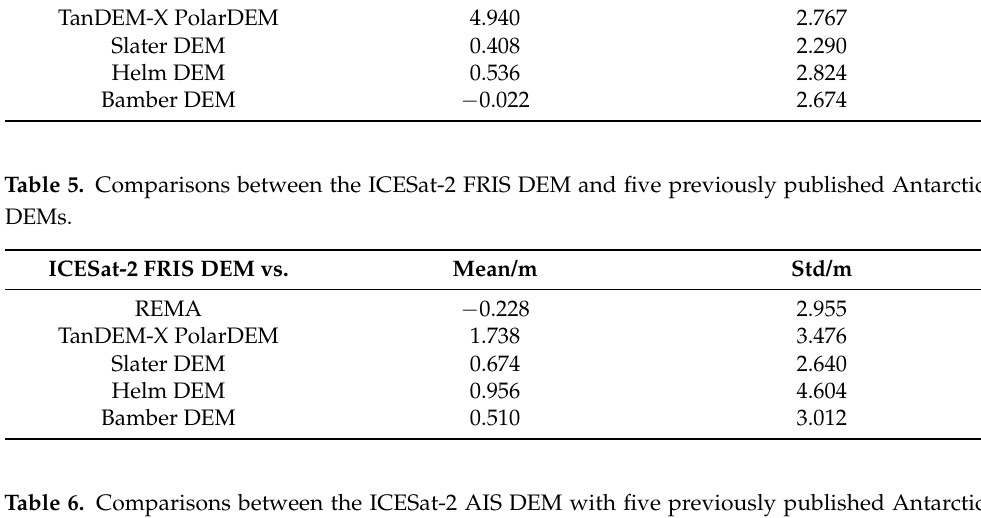
Table 6. Comparisons between the ICESat-2 AIS DEM with five previously published Antarctic DEMs. ICESat-2 AIS DEM vs.